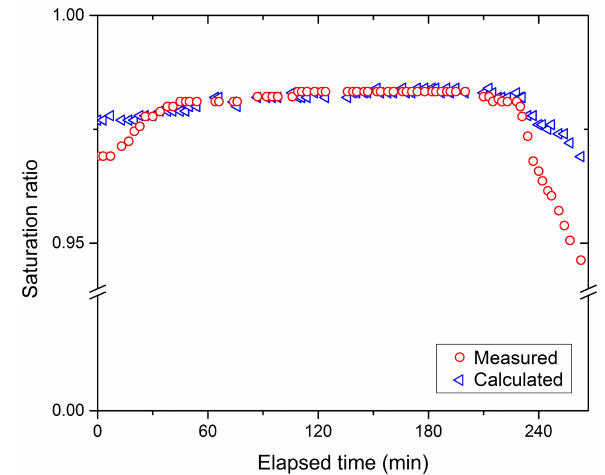
Figure 4. GF (a) and SR-calc (b) as a function of polydisperse flow rate Q p2 , with challenge (NH 4 ) 2 SO 4 aerosols of 17, 30, and 51nm. Figure 5. SR as a function of elapsed time since last wetting for pure particles of (NH 4 ) 2 SO 4 . The uncertainty in the SR (calculated) is approximately